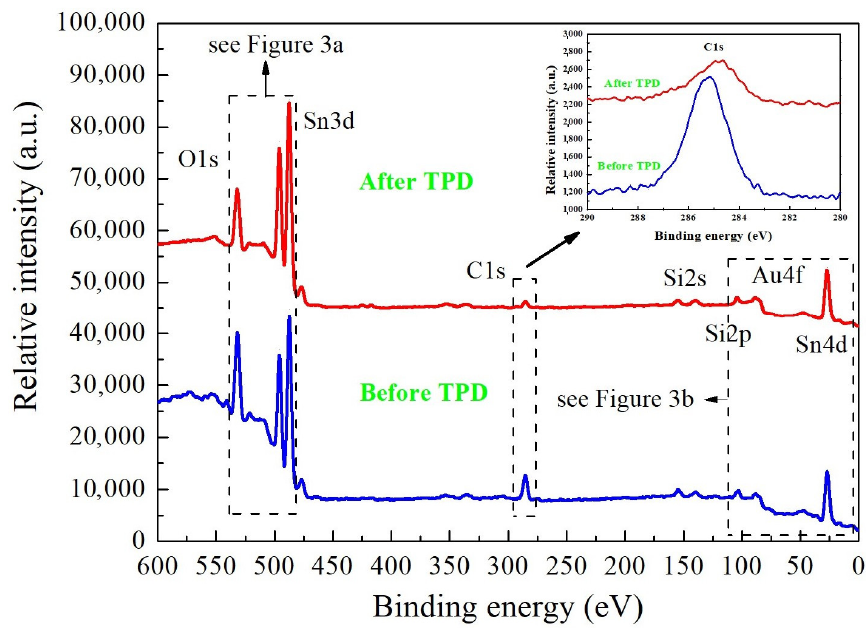
Figure 2. X-ray photoelectron spectroscopy (XPS) survey spectra with main core level lines of the VPD SnO 2 nanowires deposited on Au-covered Si substrate before and after the programmable linear growth of the sample temperature (TPD)